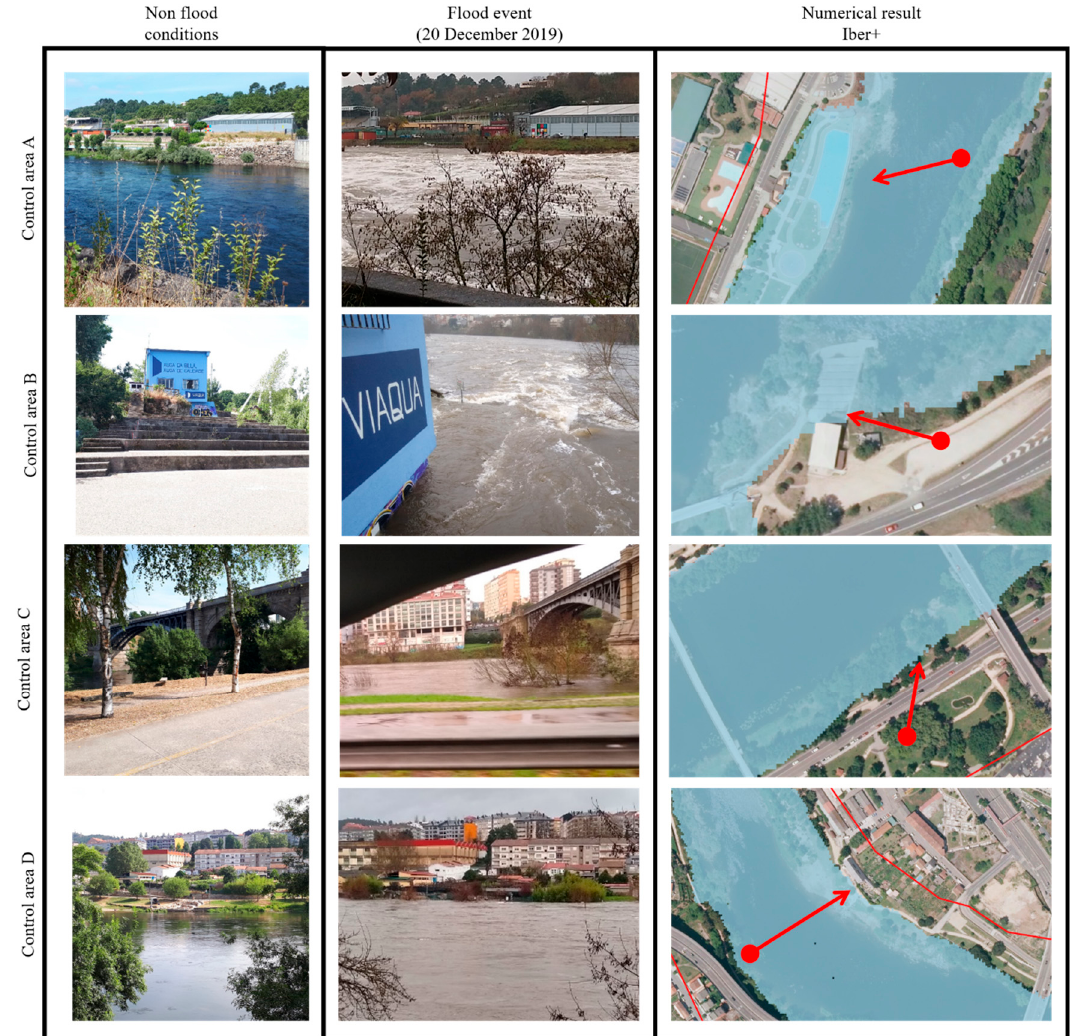
Figure 6. Results of flood extent for each control area. First column depicts non ‐ flood conditions ( Q = 265 m 3 s − 1 that corresponds to 66th percentile) at the control areas. The second column shows the images (photographs taken by one of the authors) of the flood event (20 December 2019, 16:00 to 16:30) and the third column shows the numerical results obtained with Iber+. Red arrows in the third column represent the direction of the photograph taken during the flood event.